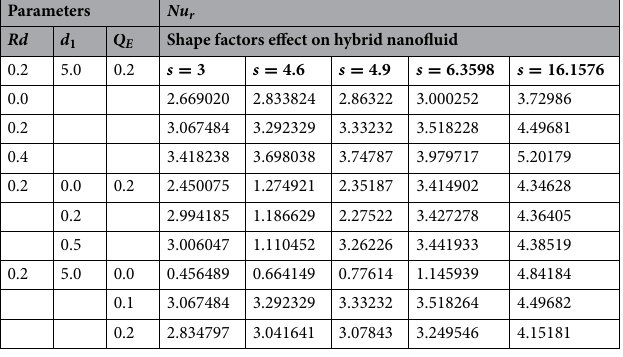
Table 6. Numerical data of (c Nu r ) versus various parameters and shape